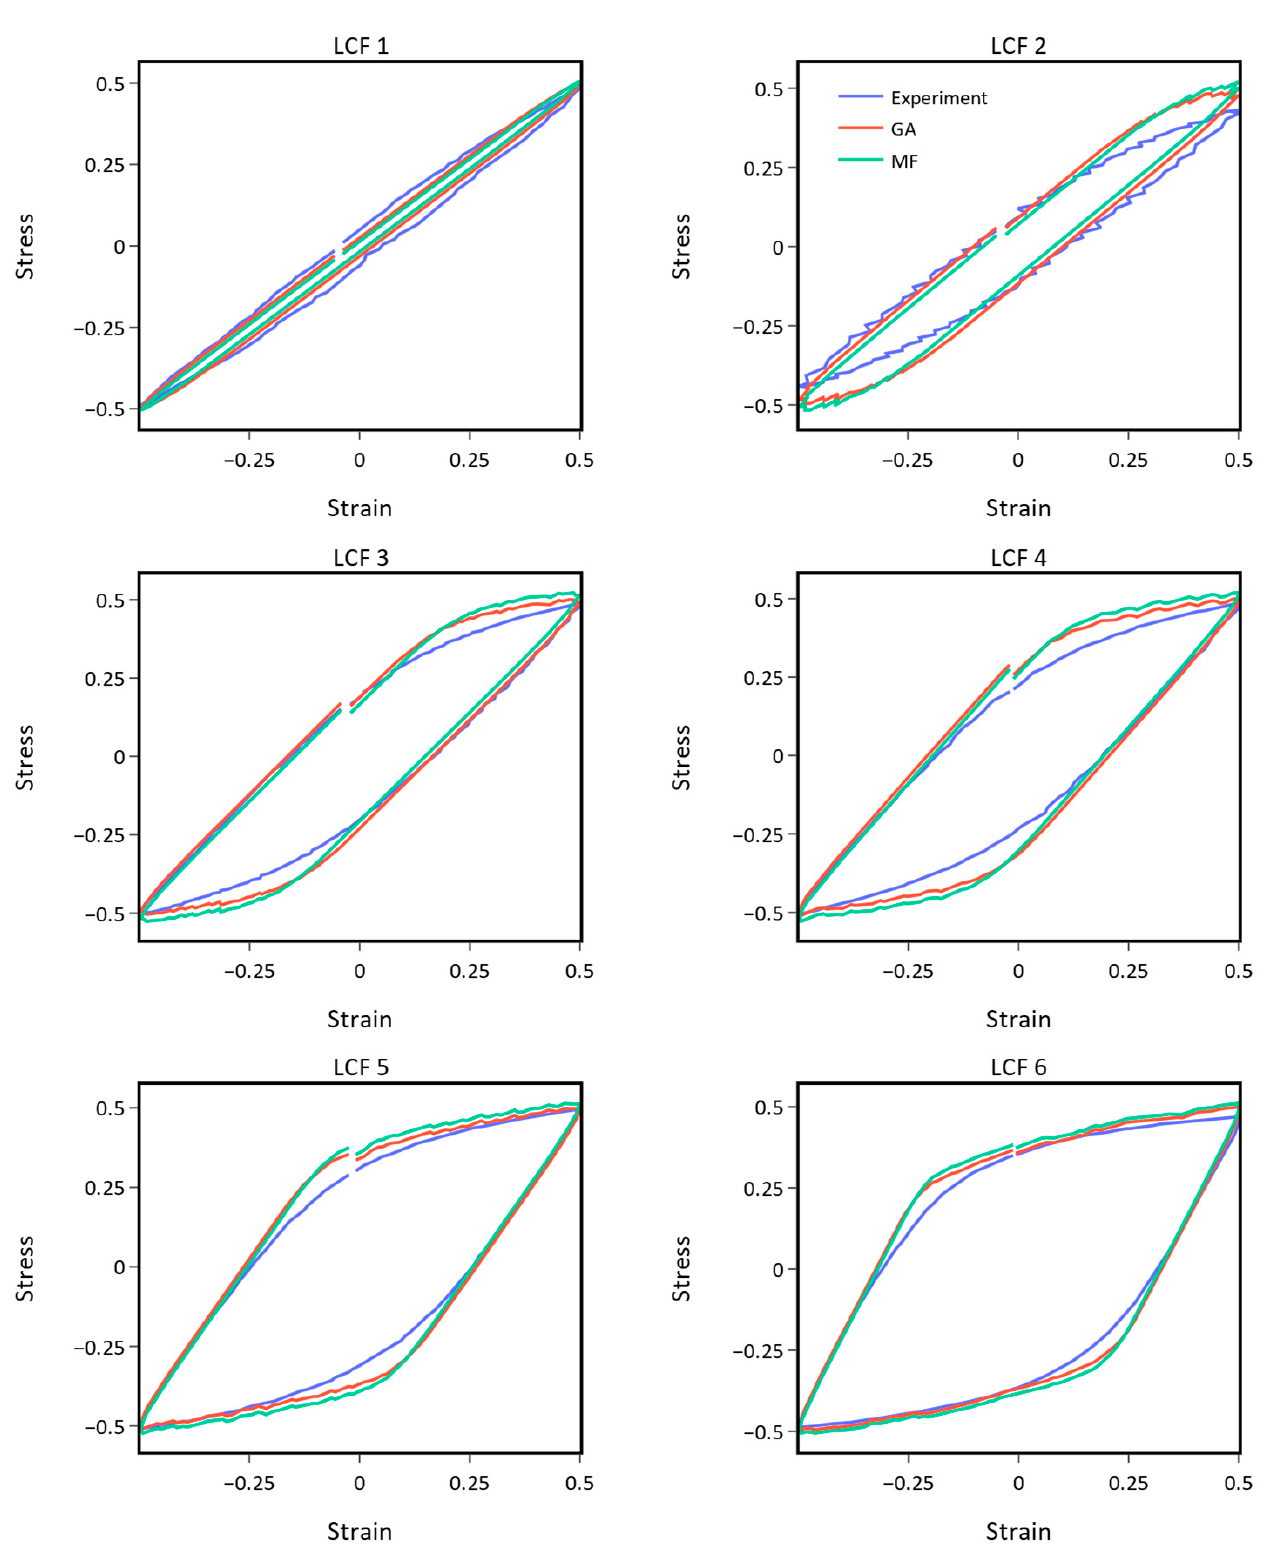
Figure A1. GA and MF methods compared to the experimental curves LCF 1–6.